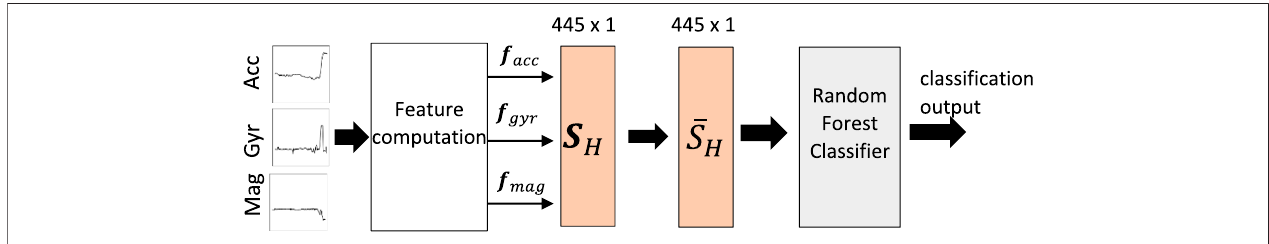
FIGURE 14 | Classical machine learning pipeline based on random forest.